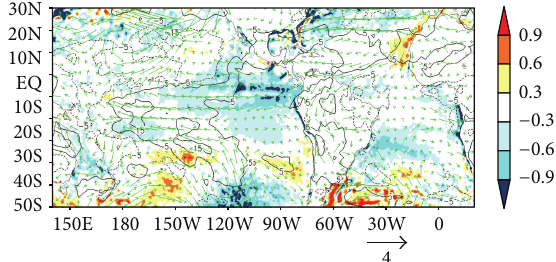
Figure 8: Composite anomalies of SST (shaded), wind (stream arrow)andOLR(contour)duringDJForAustralsummerseasonfor all extremely high-streamflow events associated with La Ni˜na. Unit for SST is ∘ C, for wind is ms −1 , and for OLR is w/m 2 . Values above 95% confidence level from a two-tailed Student’s 𝑡 test are shown.